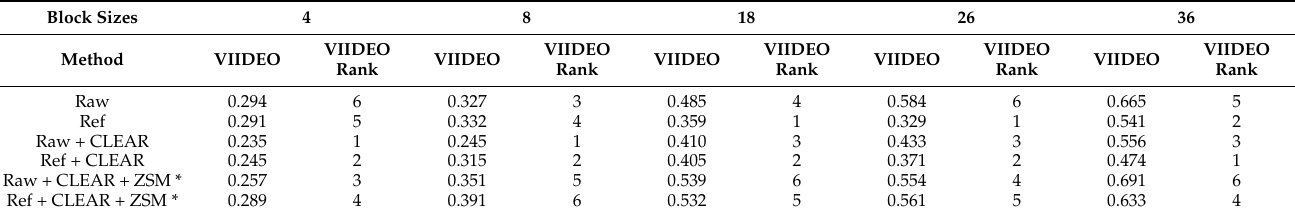
Table 5. Block size selection for the ‘Building’ sequence.